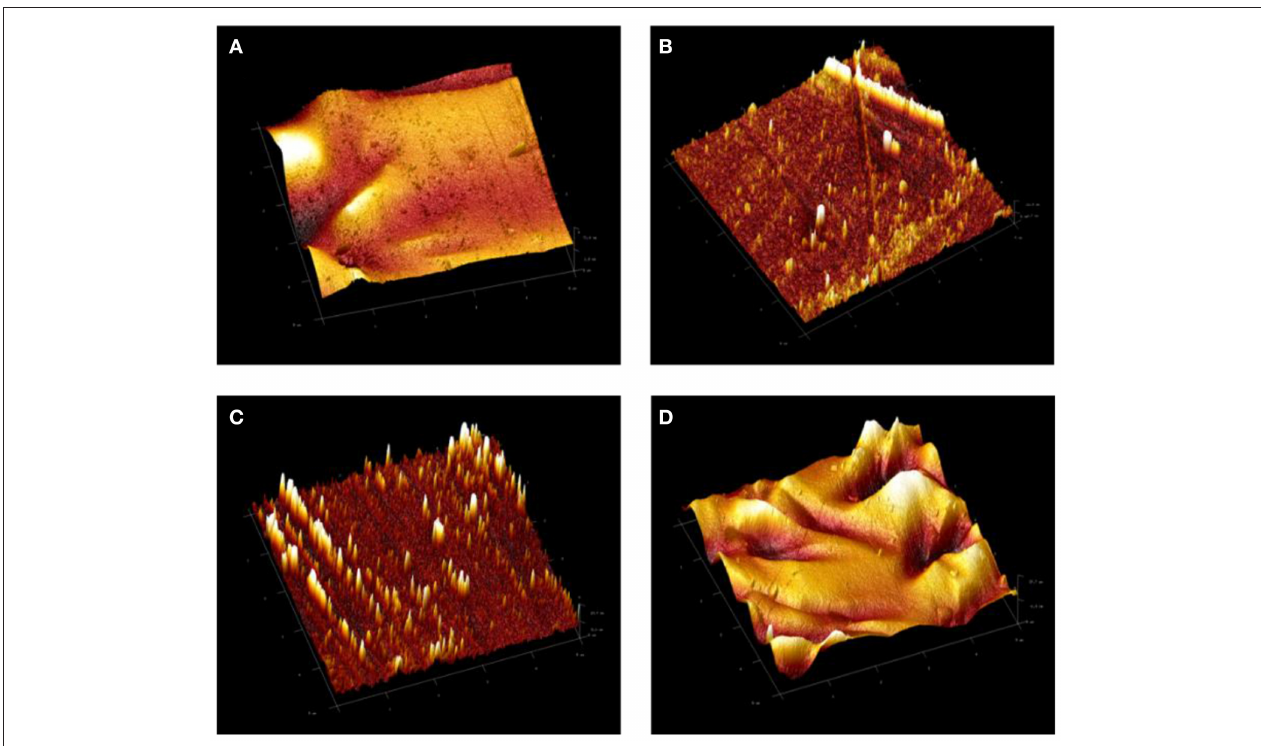
FIGURE 4 | 3D atomic force microscopy (AFM) images of (A) neat epoxy, E, coating system and (B) ET1, (C) ET2, and (D) ET3 epoxy-TiO 2 nanocomposite coating systems.